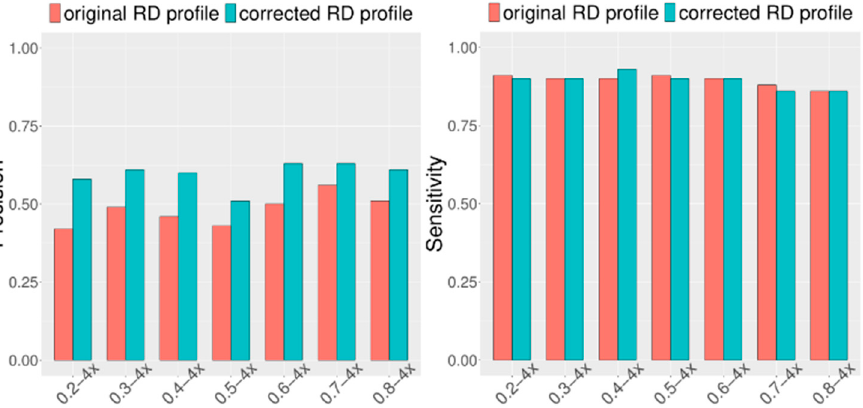
Figure 4. Performance comparisons between the first-round (using original RD profile) and the second-round (using corrected RD profile) CNV detected by the CIRCNV method with respect to sensitivity and precision. The simulation tumor purity ranges from 0.2 to 0.8, and the sequencing coverage depth is 4×.